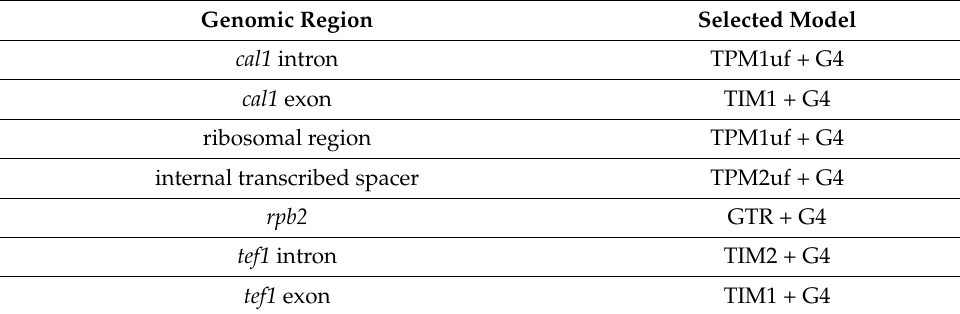
Table 2. Best fit evolutionary models selected by